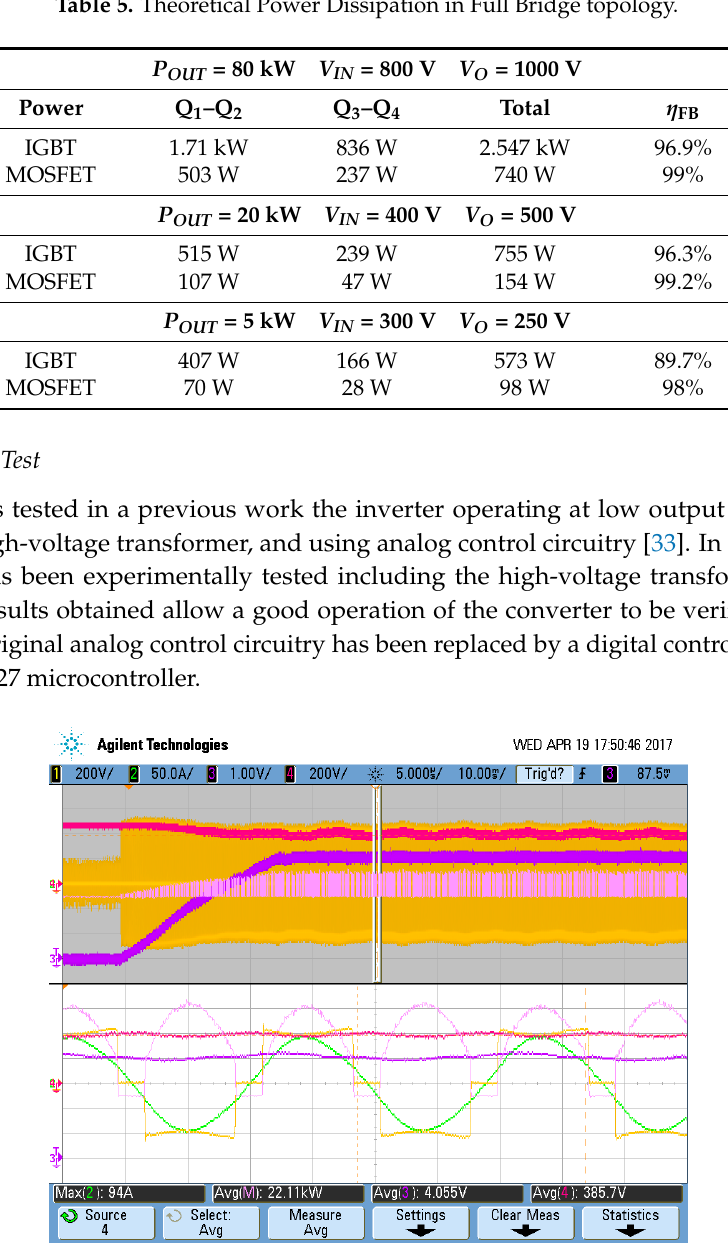
Figure 20. Experimental waveforms for V AB (yellow) and i PL (green), with V IN = 385 V (red), V O = 40 kV (magenta) and P O = 22